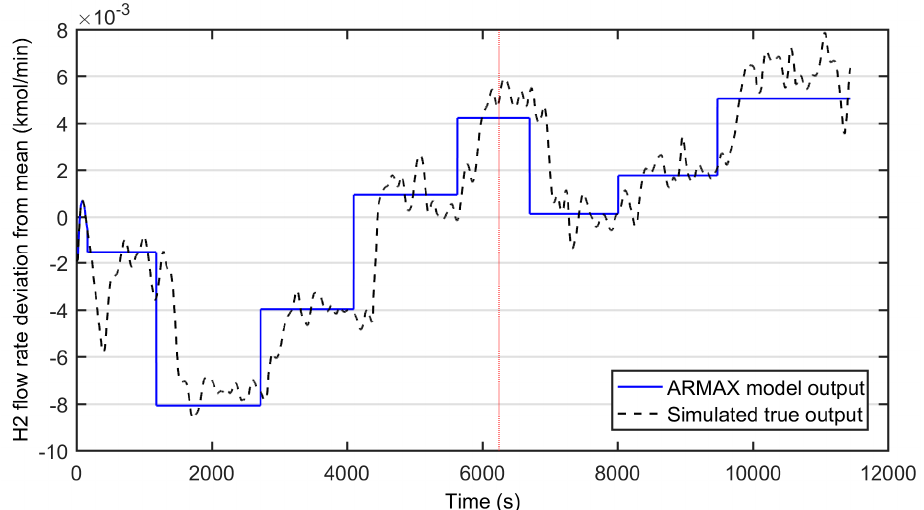
Figure 3. Modeling results of the autoregressive moving average model with exogenous input (ARMAX)-model for the water-ethanol ratio as input and hydrogen flow rate as modeled output (mean removed). Solid line: the modeled hydrogen flow rate, dashed line: simulated true output, dotted line: division of training (on right) and testing data (on